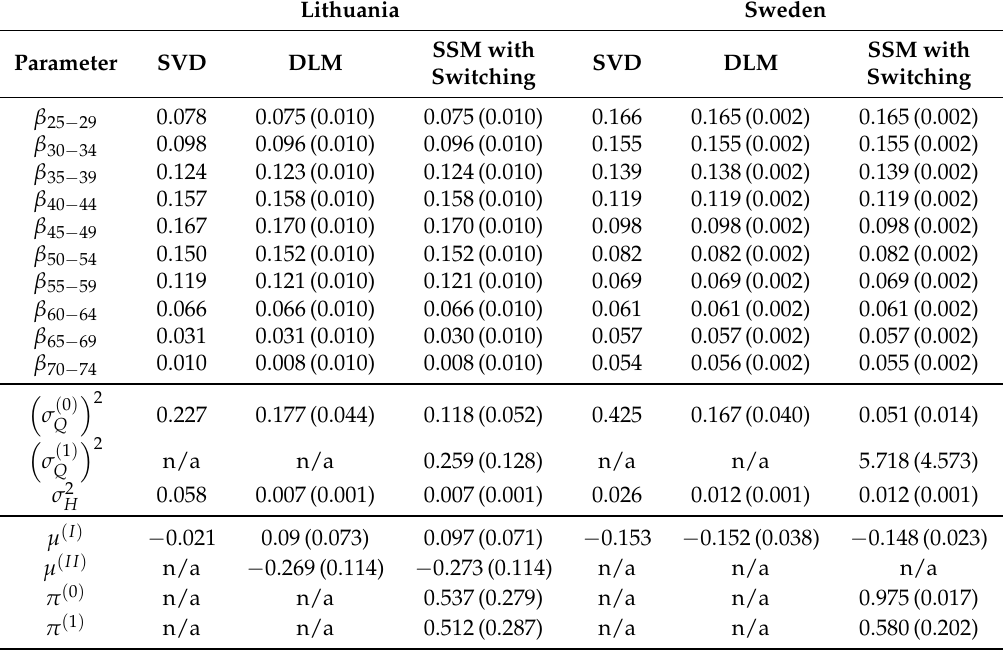
Table 3. Estimates of parameters using singular value decomposition of the classical Lee-Carter model (SVD), DLM and SSM with switching. For DLM and SSM with switching models, marginal posterior standard deviations are provided in